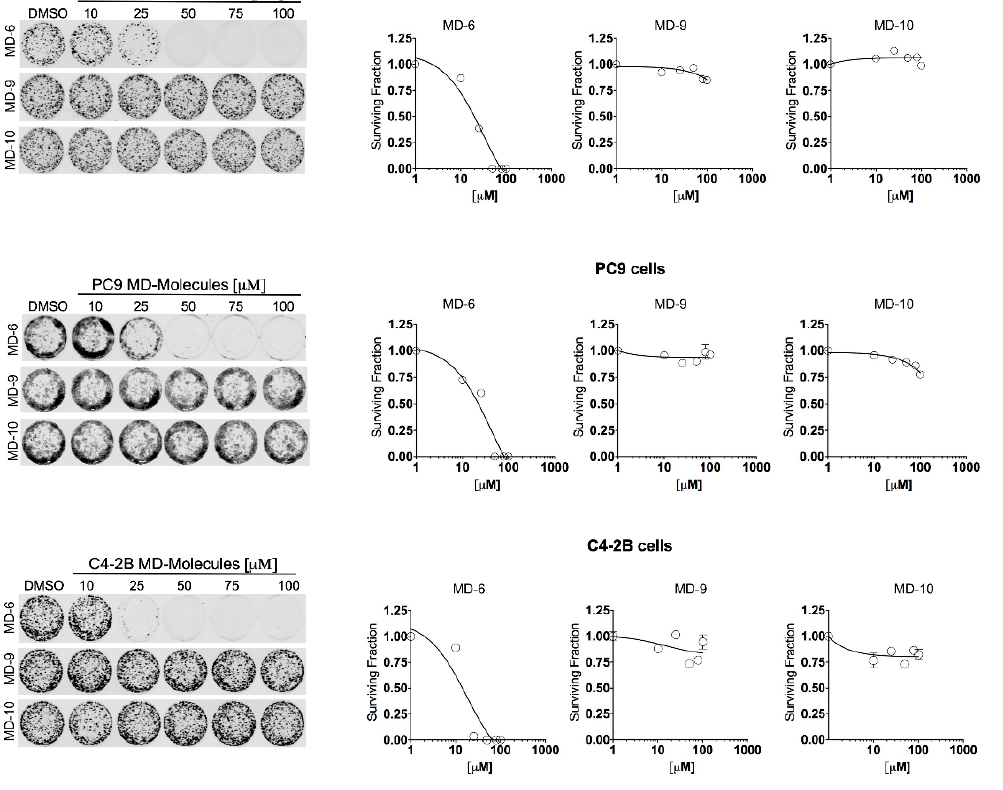
Figure 7. Cytotoxic effects of MD-6, MD-9, and MD-10 on human cancer cells. The cytotoxicity of isolated molecules were evaluated by clonogenic assay on MCF-7, PC9, and C4-2B cells treated with increased concentrations of MD-6, MD-9, and MD-10 for 24 h.